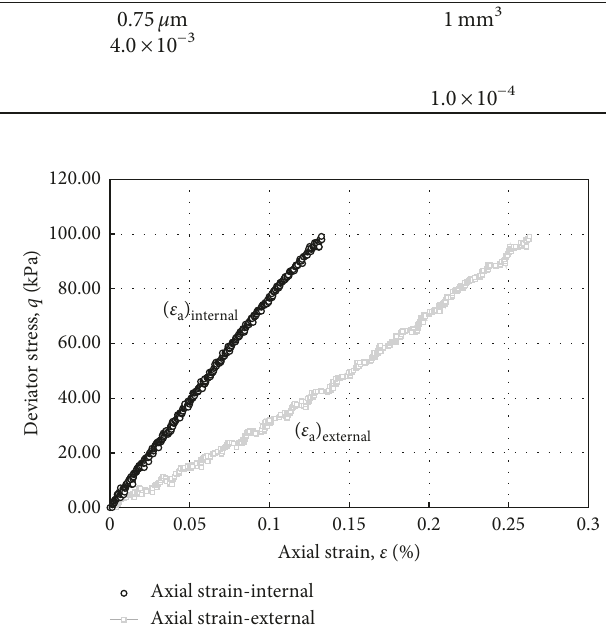
Figure 12: Stress-strain curve during K 0 y = 793.04 x R 2 = 0.97